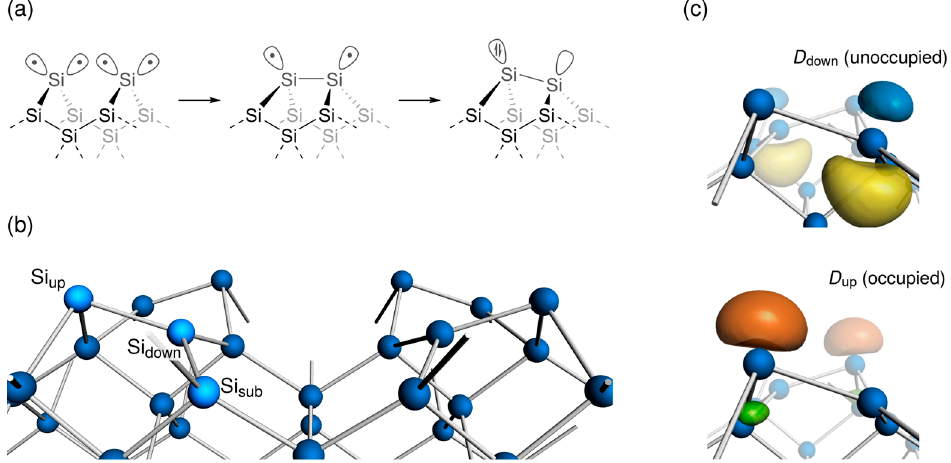
Figure 1. ( a ) Schematic depiction of the Si(001) surface reconstruction process. Dots indicate unpaired electrons. ( b ) Structure of Si(001) in the most stable reconstruction, c (4 × 2), with nomenclature used subsequently. ( c ) Crystal orbitals (at the Γ point in k space) of a Si(001) slab corresponding to the dimer states, calculated at PBE-D3/TZ2P.